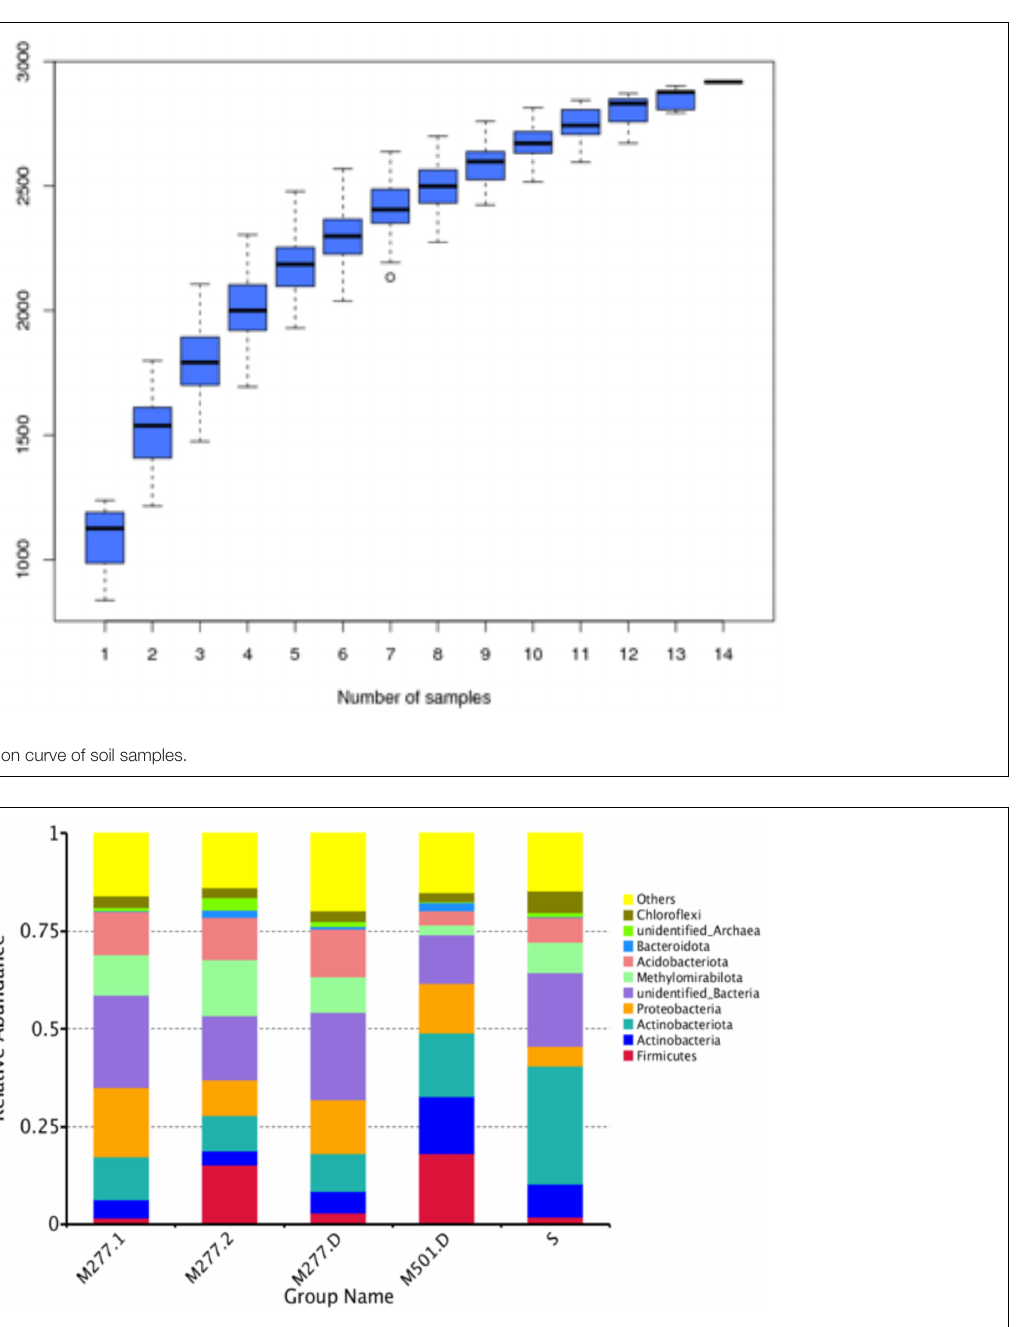
FIGURE 3 | Species abundance histogram at the phylum